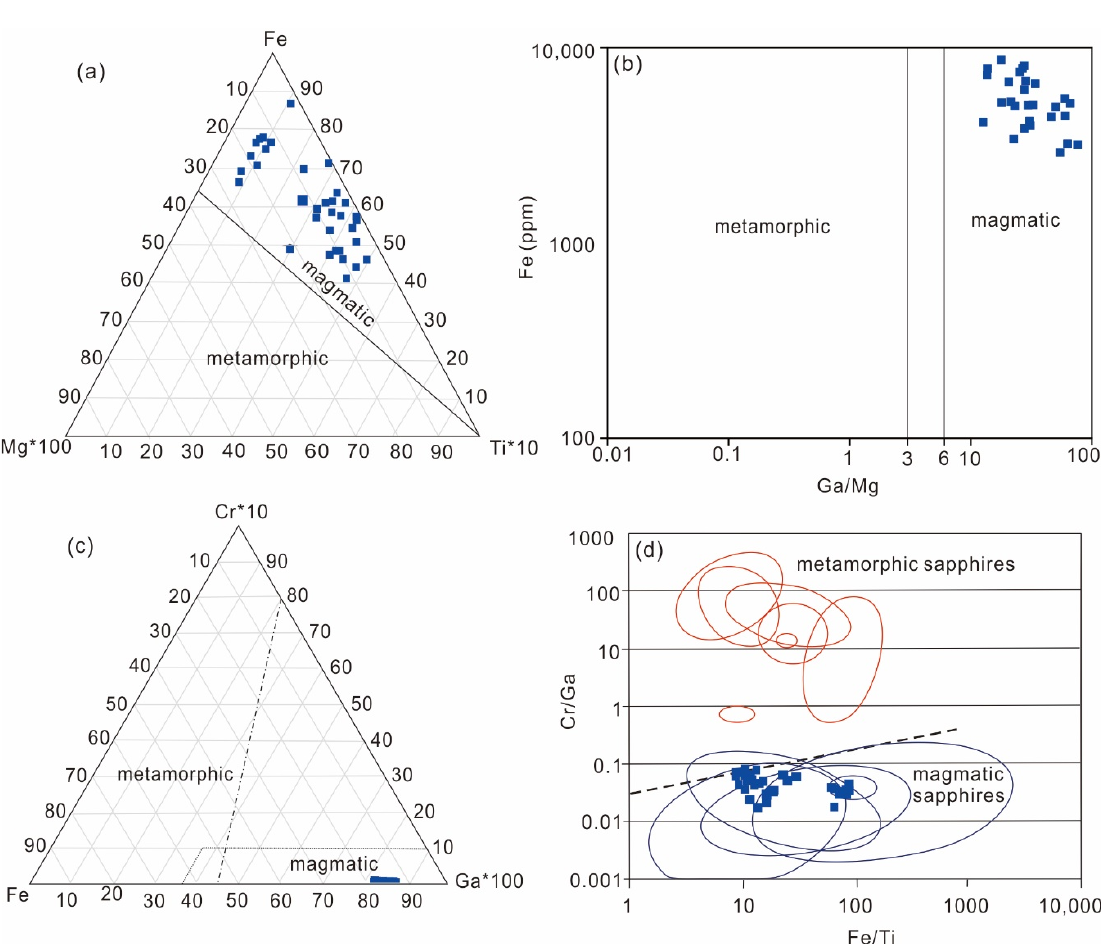
Figure 10. Variation content diagrams of trace element for identifying sapphire origin by data from the Penglai sapphire in Hainan, China: ( a ) Fe–Mg( × 100)–Ti( × 10) ternary plot [38]; ( b ) Fe–Ga/Mg chemical composition plot [39]; ( c ) Cr( × 10)–Fe–Ga( × 100) ternary plot [34,39]; ( d ) Cr/Ga versus Fe/Ti plot [34].